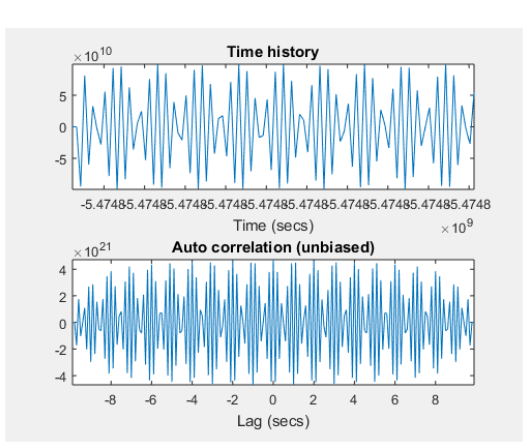
Figure 3: (a) First order perturbed wave autocorrelation, (b) Output SHG wave autocorrelation using